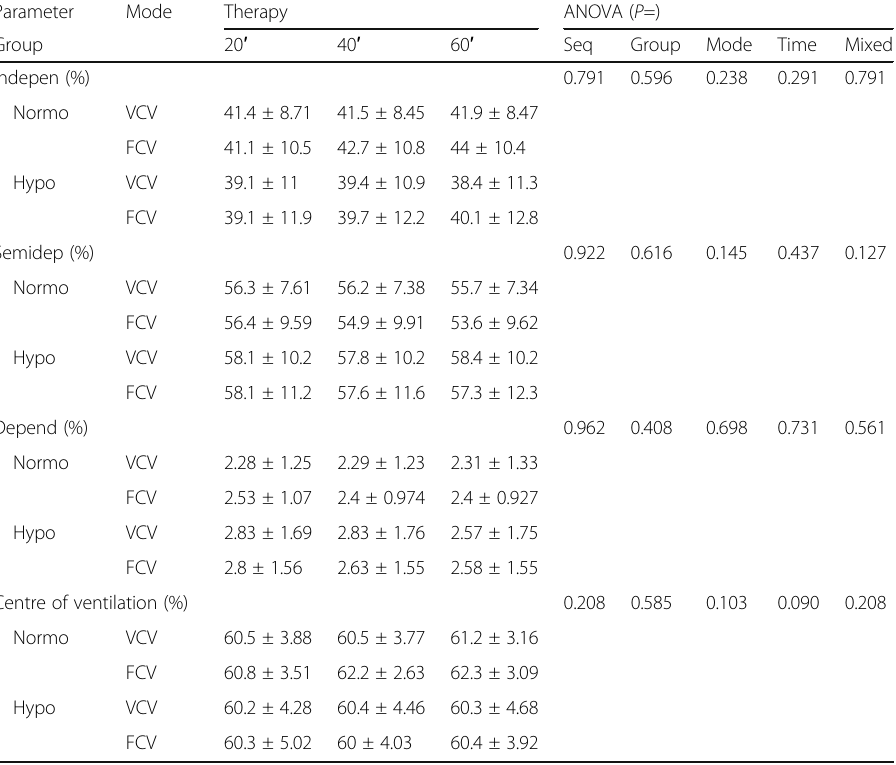
Table 5 Distribution of tidal impedance changes and centre of ventilation in the therapy lung Parameter Mode